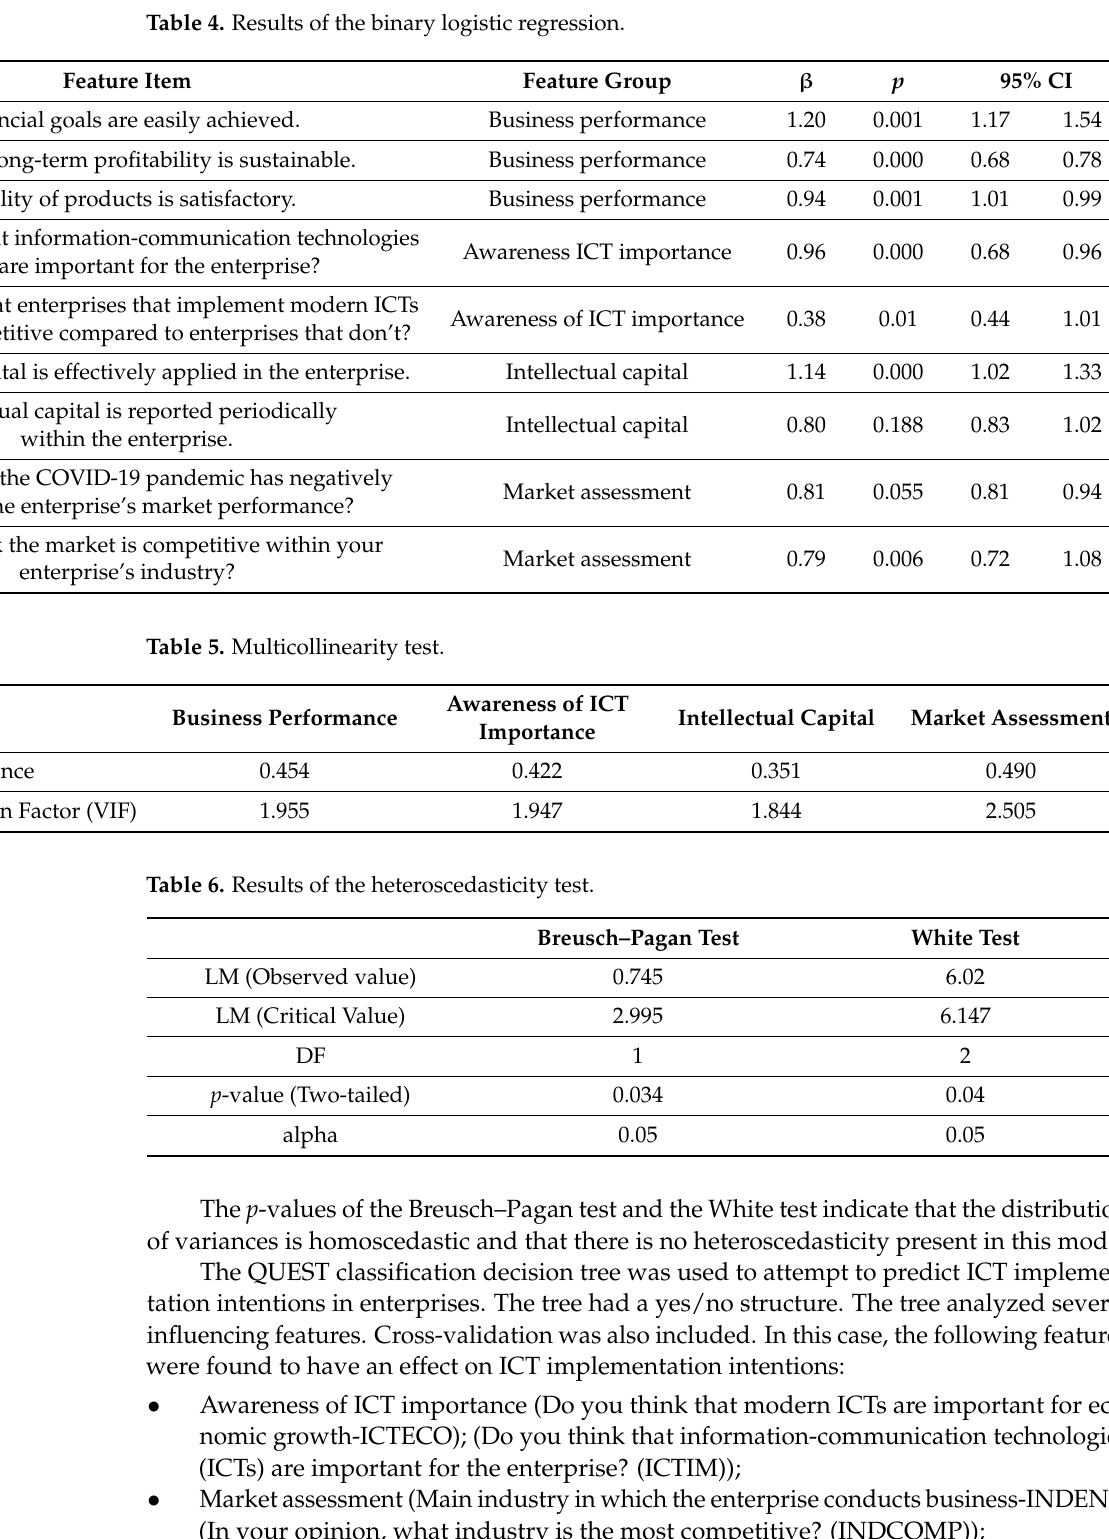
Table 4. Results of the binary logistic regression.